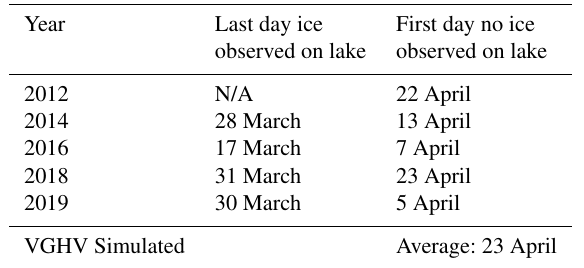
Table A3. Ice-out dates determined using satellite imagery (Planet Labs Inc.). Due to cloud cover we could not determine the exact dates of ice-out. We recorded the last day we observed ice on VGHV and the first day when we were able to observe VGHV as being completely ice-free.